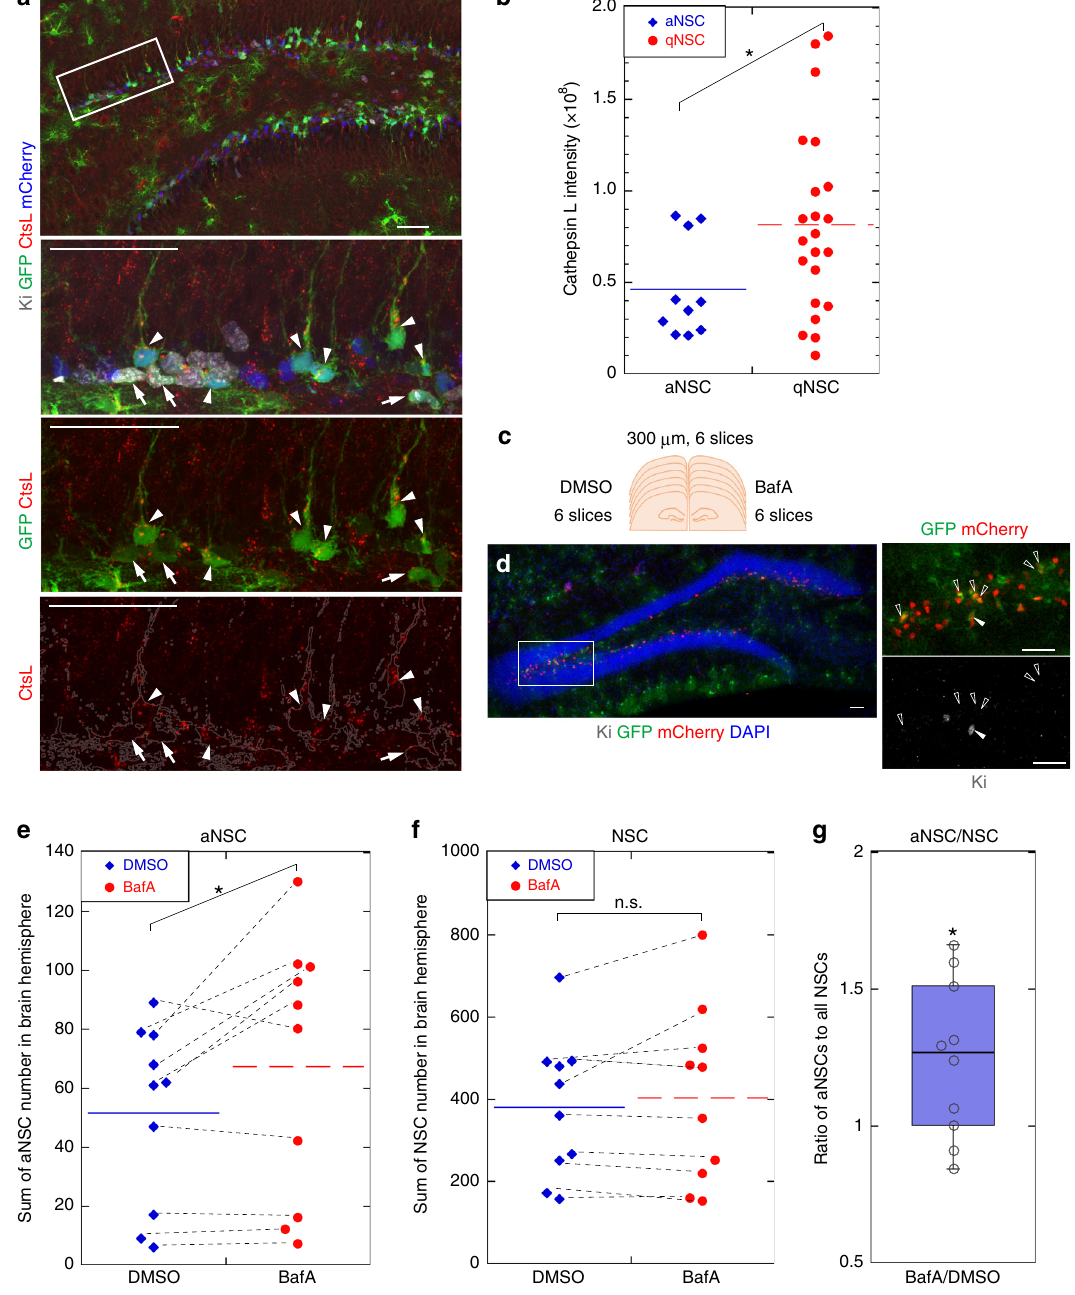
Fig. 4 Increased lysosome abundance in quiescent NSCs and lysosomal inhibition in the tissue. a Immunohistochemistry of cathepsin L in the DG of GFAP- GFP;Nestin-NLS-mCherry mice. Proliferating NSCs expressed Ki-67 (gray), GFP (green), and mCherry (blue), but qNSCs were Ki-67 – negative. The selected region indicated by a white square is enlarged below. Proliferating NSCs (arrows) exhibited lower cathepsin L (CtsL) staining than qNSCs (arrowheads). Cell shapes are indicated by gray lines in the lower panel. b Quanti fi ed values of cathepsin L intensity in individual NSCs in the DG ( n = 32 in total). c Experimental design of brain slice cultures. d Representative images of the DG stained with DAPI (blue), GFP (green), mCherry (red), and Ki (gray) at a single plane of the brain slices after the slice culture. Open and closed arrowheads indicate qNSCs and aNSCs, respectively. e , f Numbers of Ki-67, GFP, and mCherry triple-positive cells (aNSCs ( e )), and GFP and mCherry double-positive cells (NSCs ( f )) in the SGZ of brain slices from 6-month-old mice cultured with DMSO (vehicle) or BafA. Dot plots show the sums of numbers of aNSCs ( e ) and NSCs ( f ) in individual hemispheres. Average values in each data set are shown by cross bars, and dotted lines link results from the same individuals. g Box plot showing the proportion of aNSCs in NSCs (center line, median; box limits, upper and lower quartiles; whiskers, minimum and maximum). Corresponding data points was plotted as dots. BafA increased the proportion of aNSCs to total NSCs in the DG. Scale bars, 50 µ m. Data represent means± s.e.m. (* P < 0.05; n.s., not signi fi cant; Student ’ s t -test, n = 10 for e – g